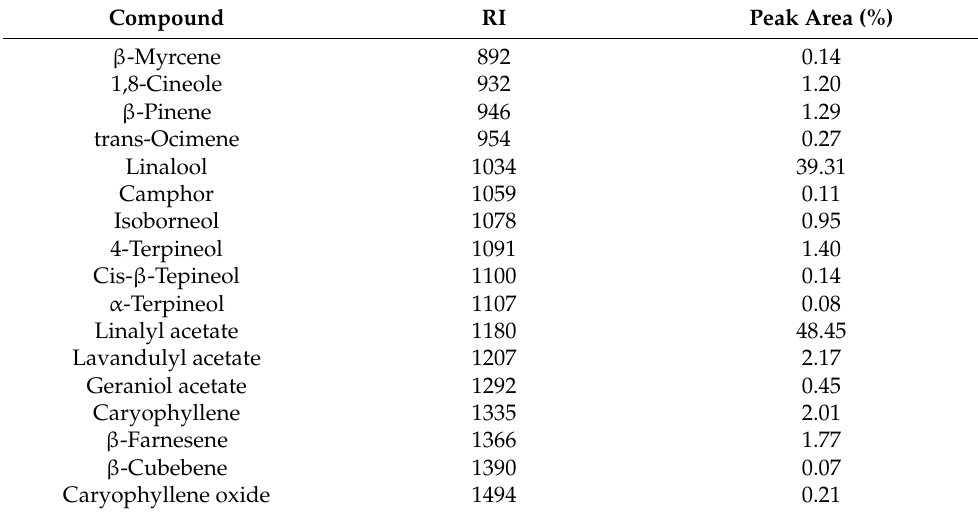
Table 1. Chemical composition of Lavandula angustifolia essential oils. RI represents Kovats retention index.